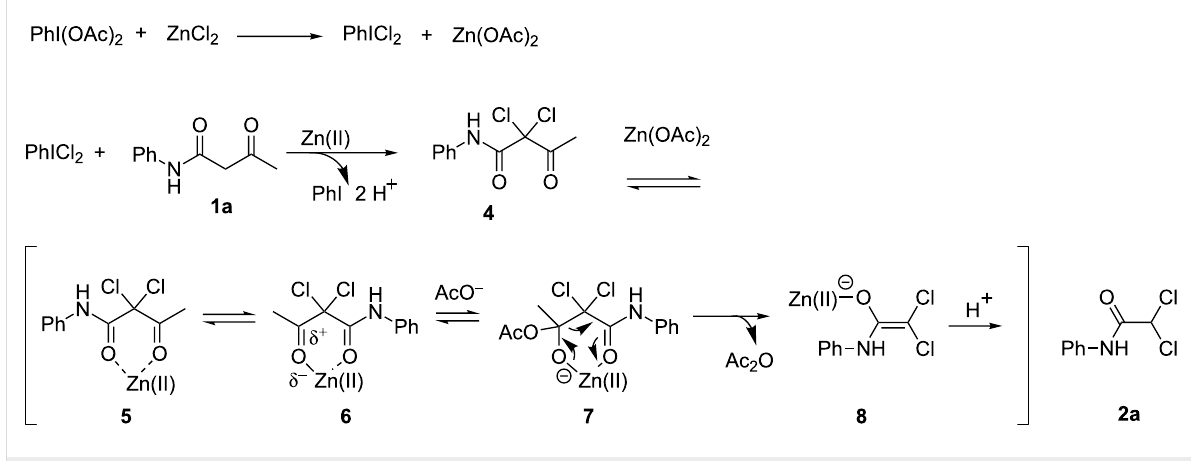
Scheme 6: Tentative mechanism for the synthesis of 2,2-dihalo- N -phenylacetamides.